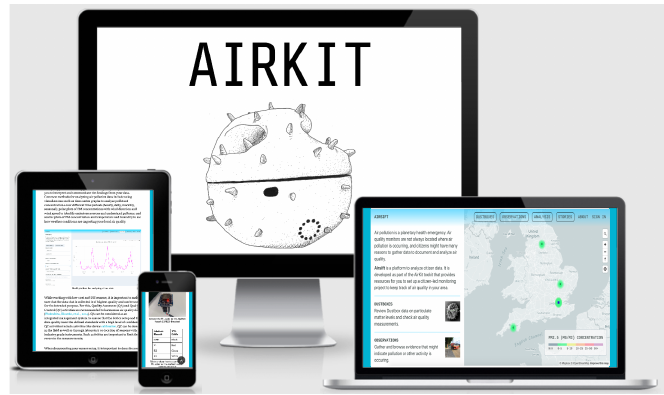
Figure 12. Airsift data platform and AirKit